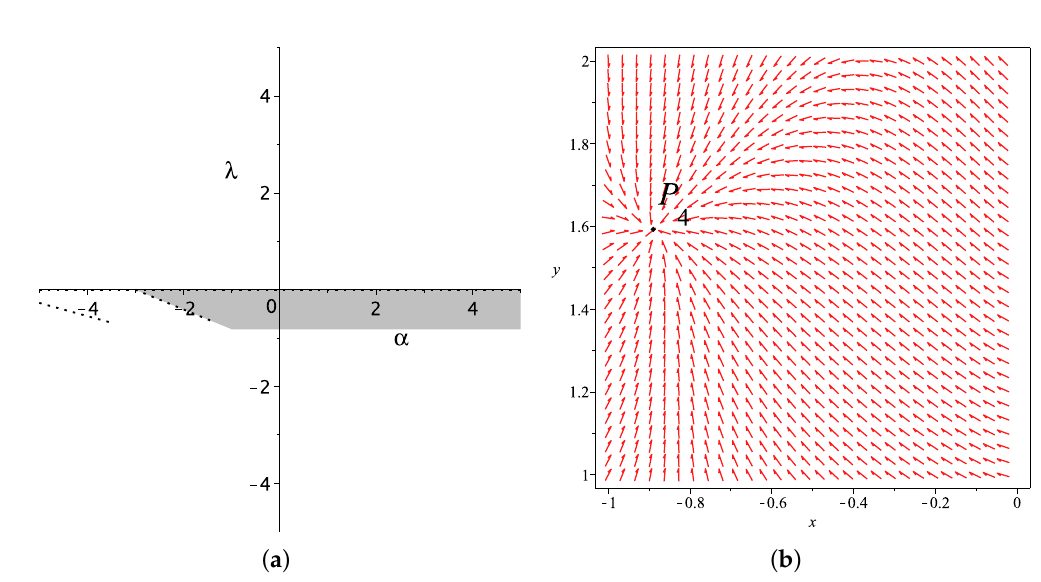
Figure 3. ( a ) The value range for parameters λ and α to make the critical point P 4 exist and stable, also being constrained by other cosmological quantities, when x < 0. ( b ) The phase plane for λ = − 0.5 and